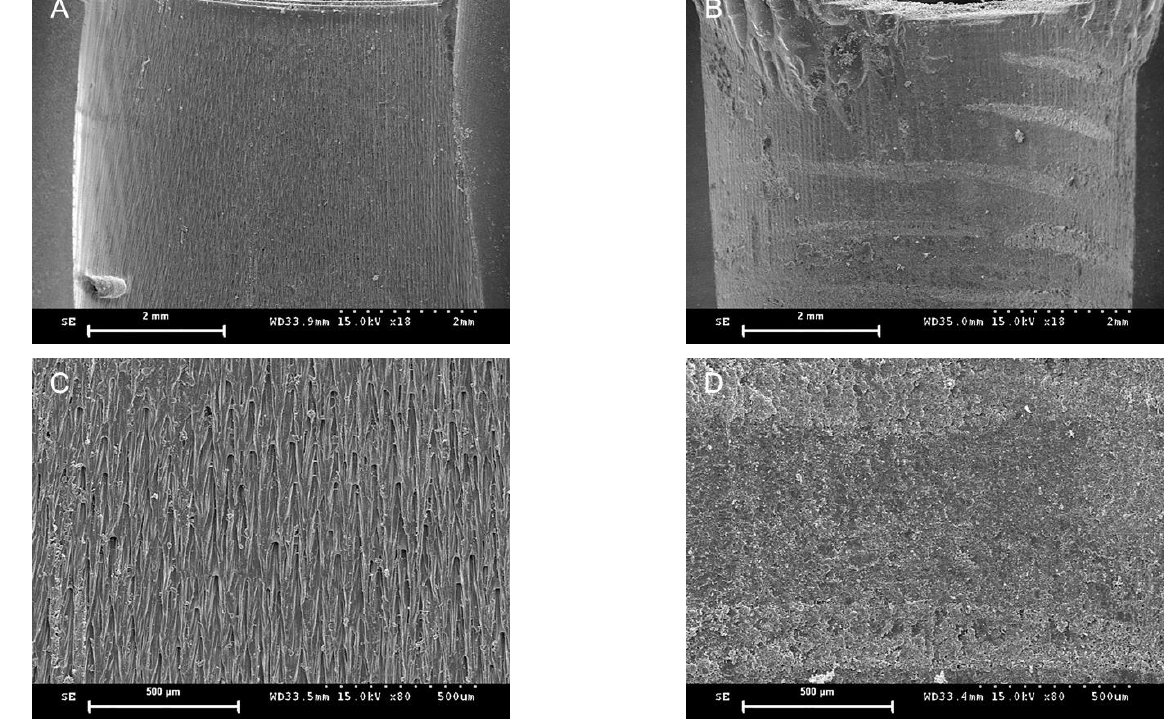
Figure 6. Representative scanning electron microscopic images. Cross-sectional view of a sleeve insert from a preoperative ( A ) and a postoperative ( B ) image from the MSF group in a lower magnification (18×). Cross-sectional view of a sleeve insert from a preoperative ( C ) and a postoperative ( D ) image from the MSF group at a higher magnification (80×).